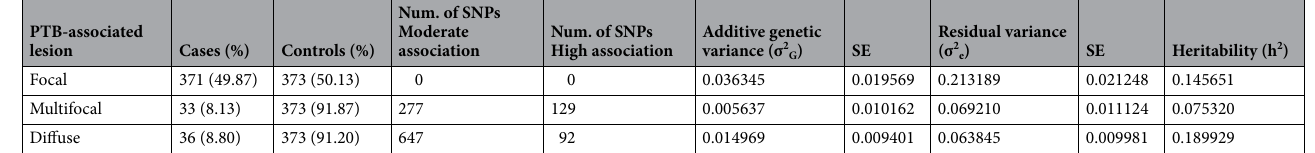
Table 1. Number of cases and controls, variance components, standard errors (SE), and h 2